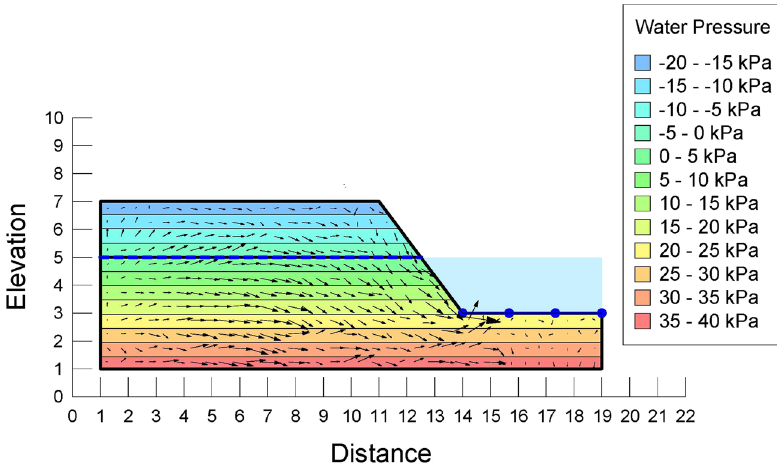
Figure 6: Steady state seepage ( SEEP/W ) after applying rationing